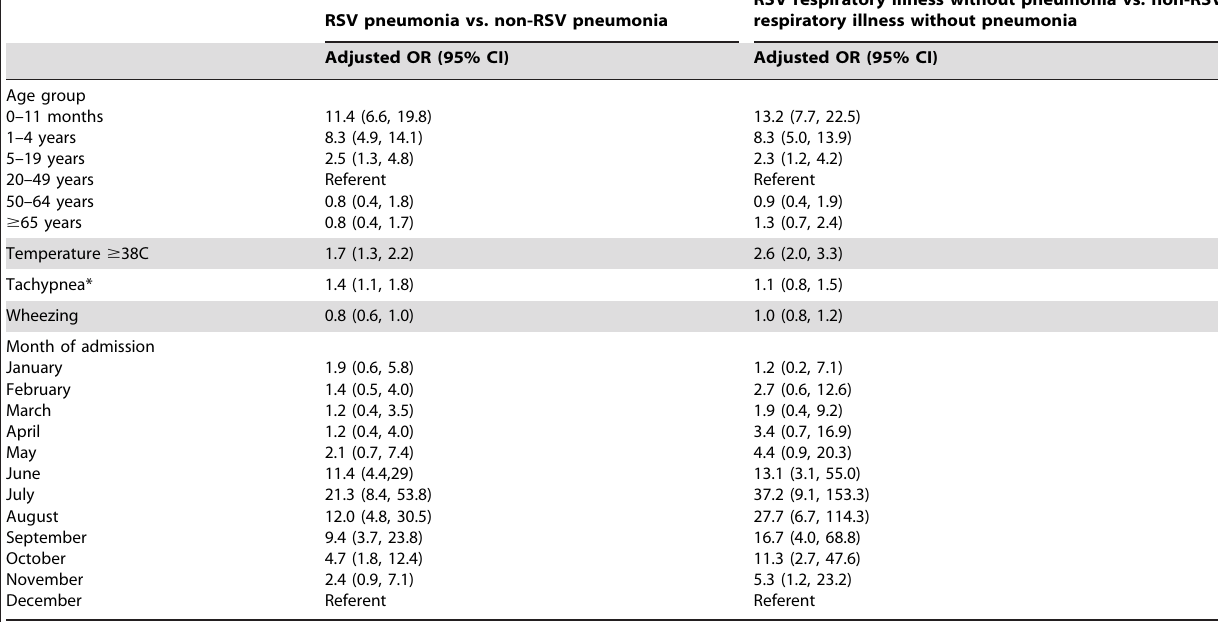
Table 2. Independent predictors for RSV radiographically-confirmed pneumonia compared to non-RSV radiographically- confirmed pneumonia and for RSV respiratory illness without pneumonia compared to non-RSV respiratory illness without